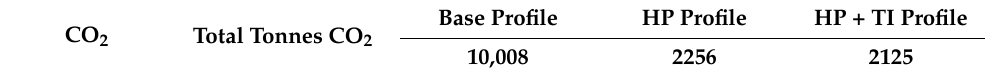
Table 3. CO 2 tonnes produced.